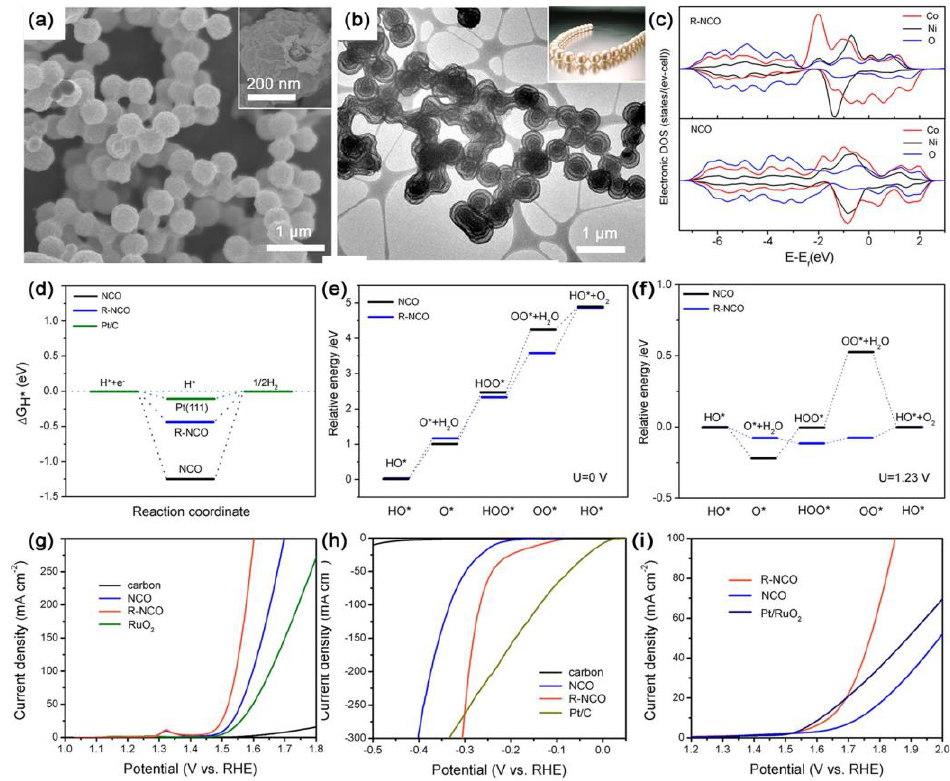
Figure 1. ( a ) SEM image and ( b ) TEM images of R-NCO. ( c ) Calculated DOS curves for pristine NCO and R-NCO. ( d ) Calculated free − energy diagram of the HER on pristine NCO and R-NCO. ( e , f ) Schematic illustration of reaction paths for OER on pristine NCO and R-NCO at ( e ) zero potential and ( f ) equilibrium potential at 1.23 V. ( g ) OER, ( h ) HER, and ( i ) overall water-splitting electrocatalytic properties of R − NCO and NCO at a scan rate of 5 mV s − 1 in 1.0 M KOH. Reproduced with permission from ref. [22]. Copyright 2018, American Chemical Society.